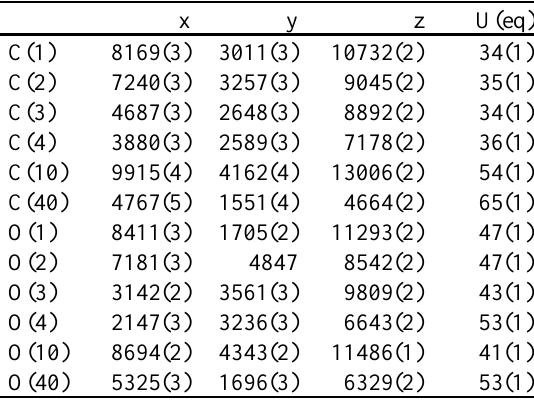
tropic displacement parameters (Å 2 x 10 3 ) for dimethyl (R,R)-(+)-tartrate. U (eq) is defined as one third of the trace of the orthogonalized U tensor. ij